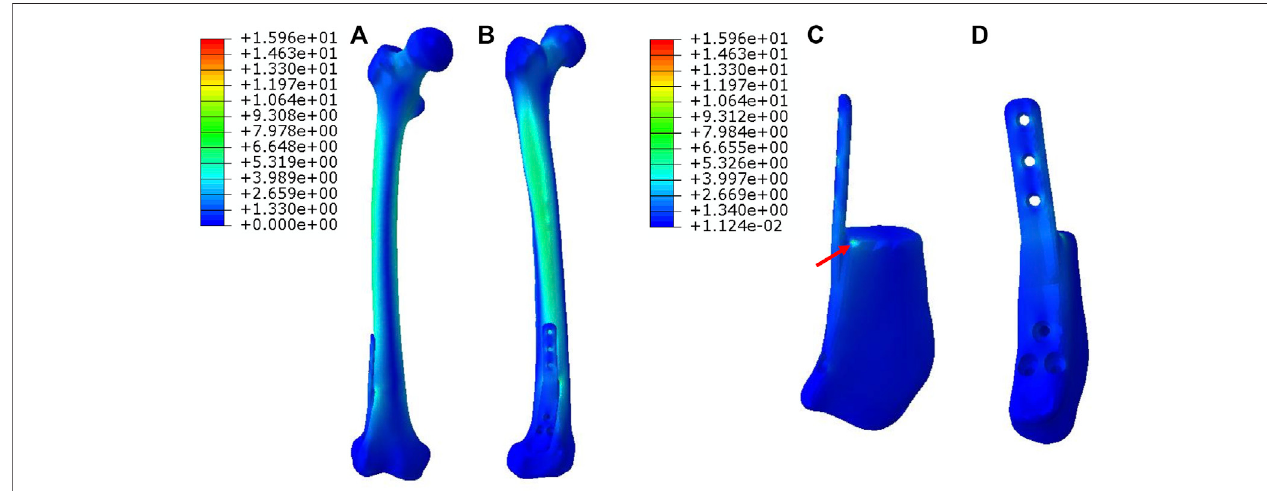
FIGURE 5 | Von Mises stress distribution in Mode III fi xation pattern, the red arrow directs the maximum stress concentration.